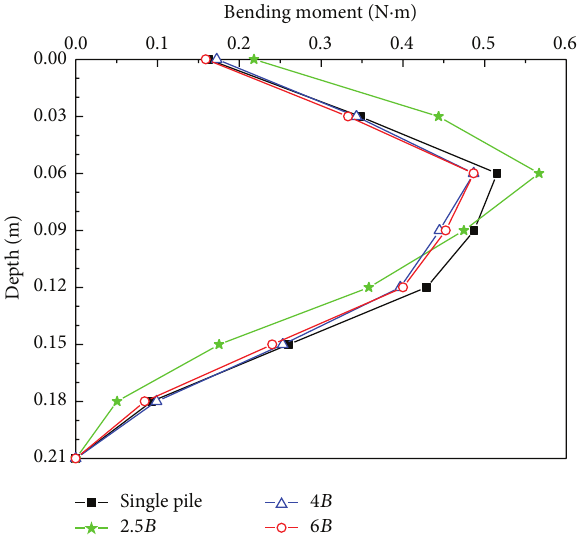
Figure 6: Lateral displacement versus depth curves from the active pile.